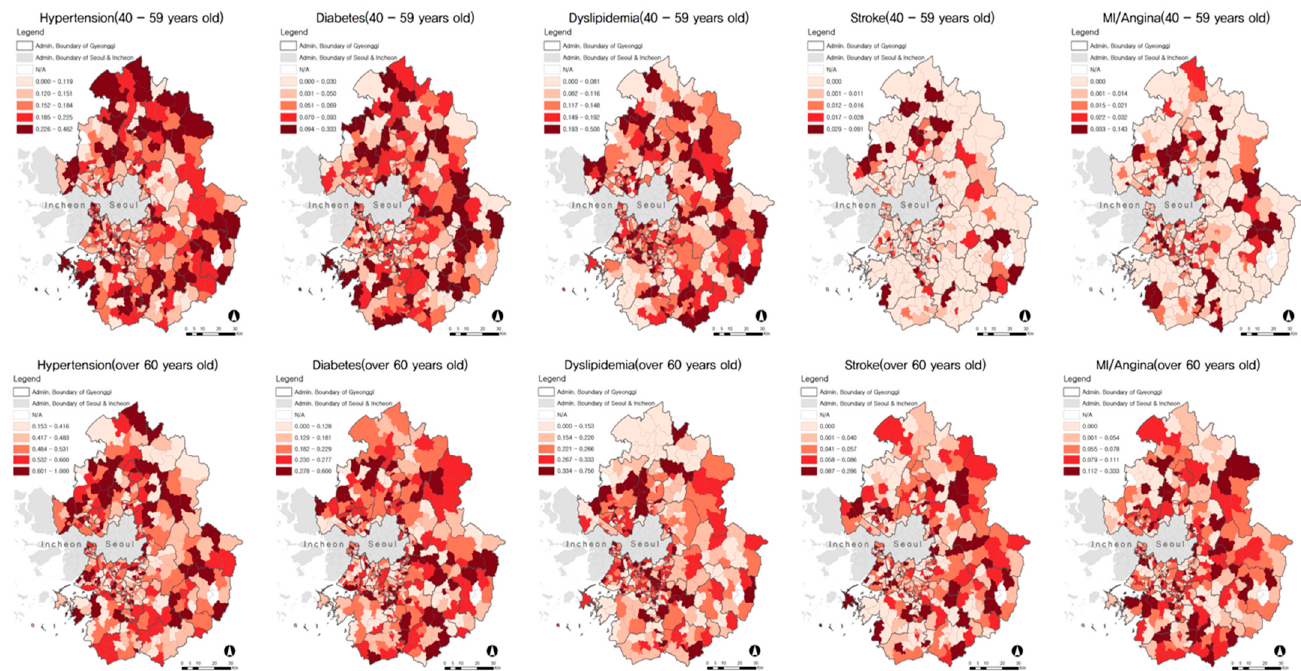
Figure 1. Spatial distribution of prevalence of cardiovascular diseases by age groups. Table 3. Association between cardiovascular diseases and built environments in adults aged 40–50 years.